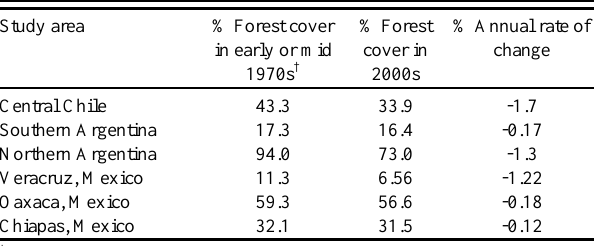
Table 1 . Percentage forest cover detected in the 1970s (1990 for Chiapas) and mid-2000s, and annual deforestation rates recorded in each study area. Data were derived from analysis of Landsat MSS, TM and ETM+ imagery, and SPOT imagery (in the case of Veracruz and Oaxaca in 2000s). For precise dates of images, see Table 3. Source: Newton and Tejedor (2011).